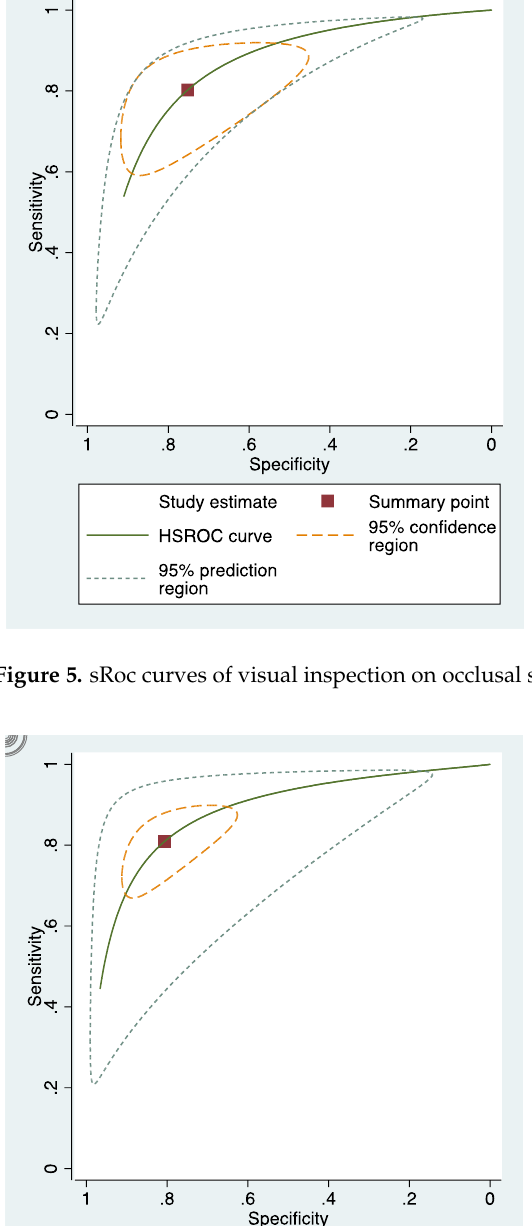
Figure 4. sRoc curves of photographic visual examination.